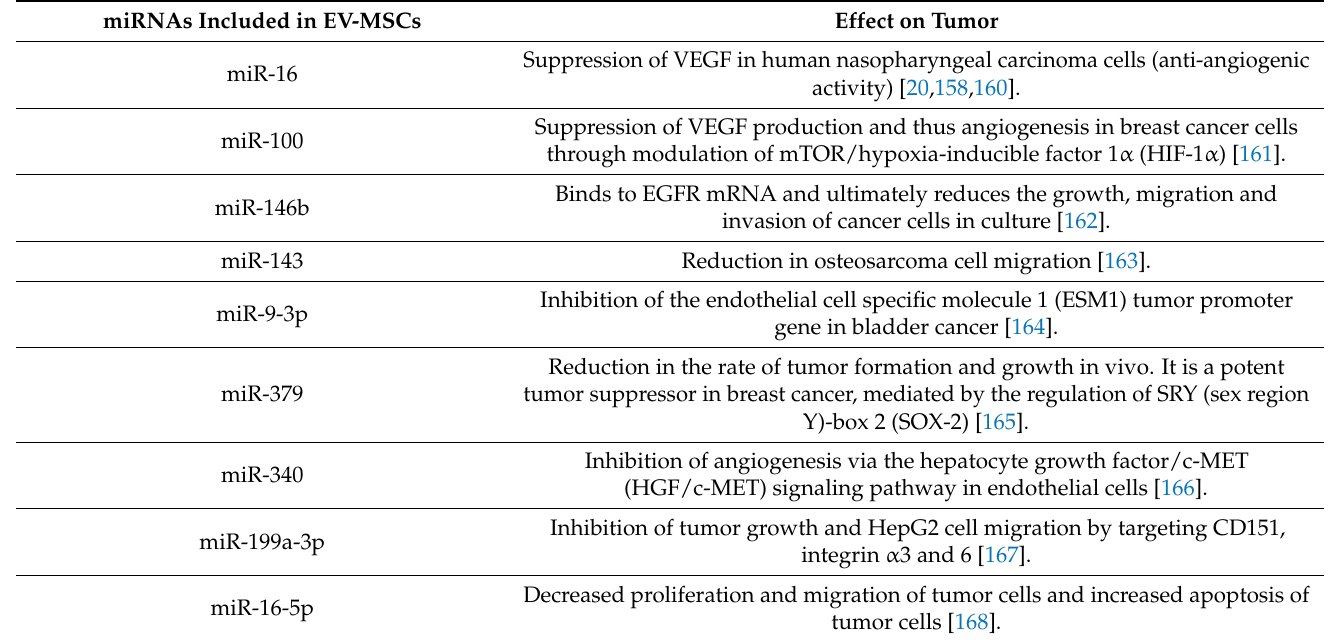
Table 3. MicroRNAs transported by vesicles and therapeutic